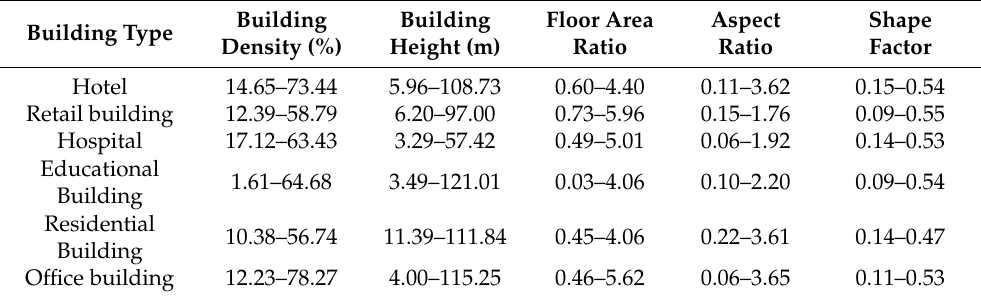
Table 3. Parameter setting of urban morphology